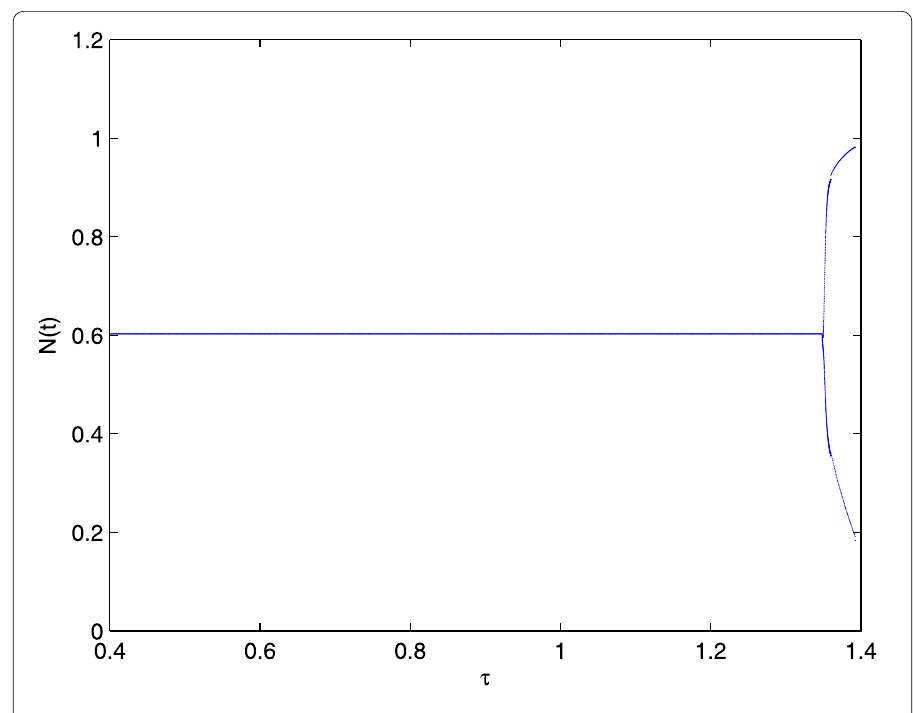
Figure 2 In the case of strong Allee effect, bifurcation diagram of system (3) with respect to τ